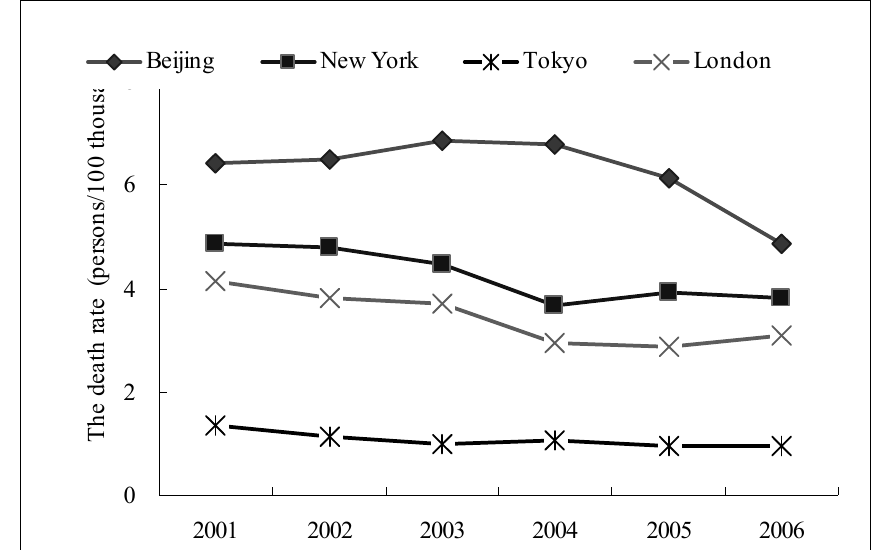
Fig. 6. Comparison of traffic death